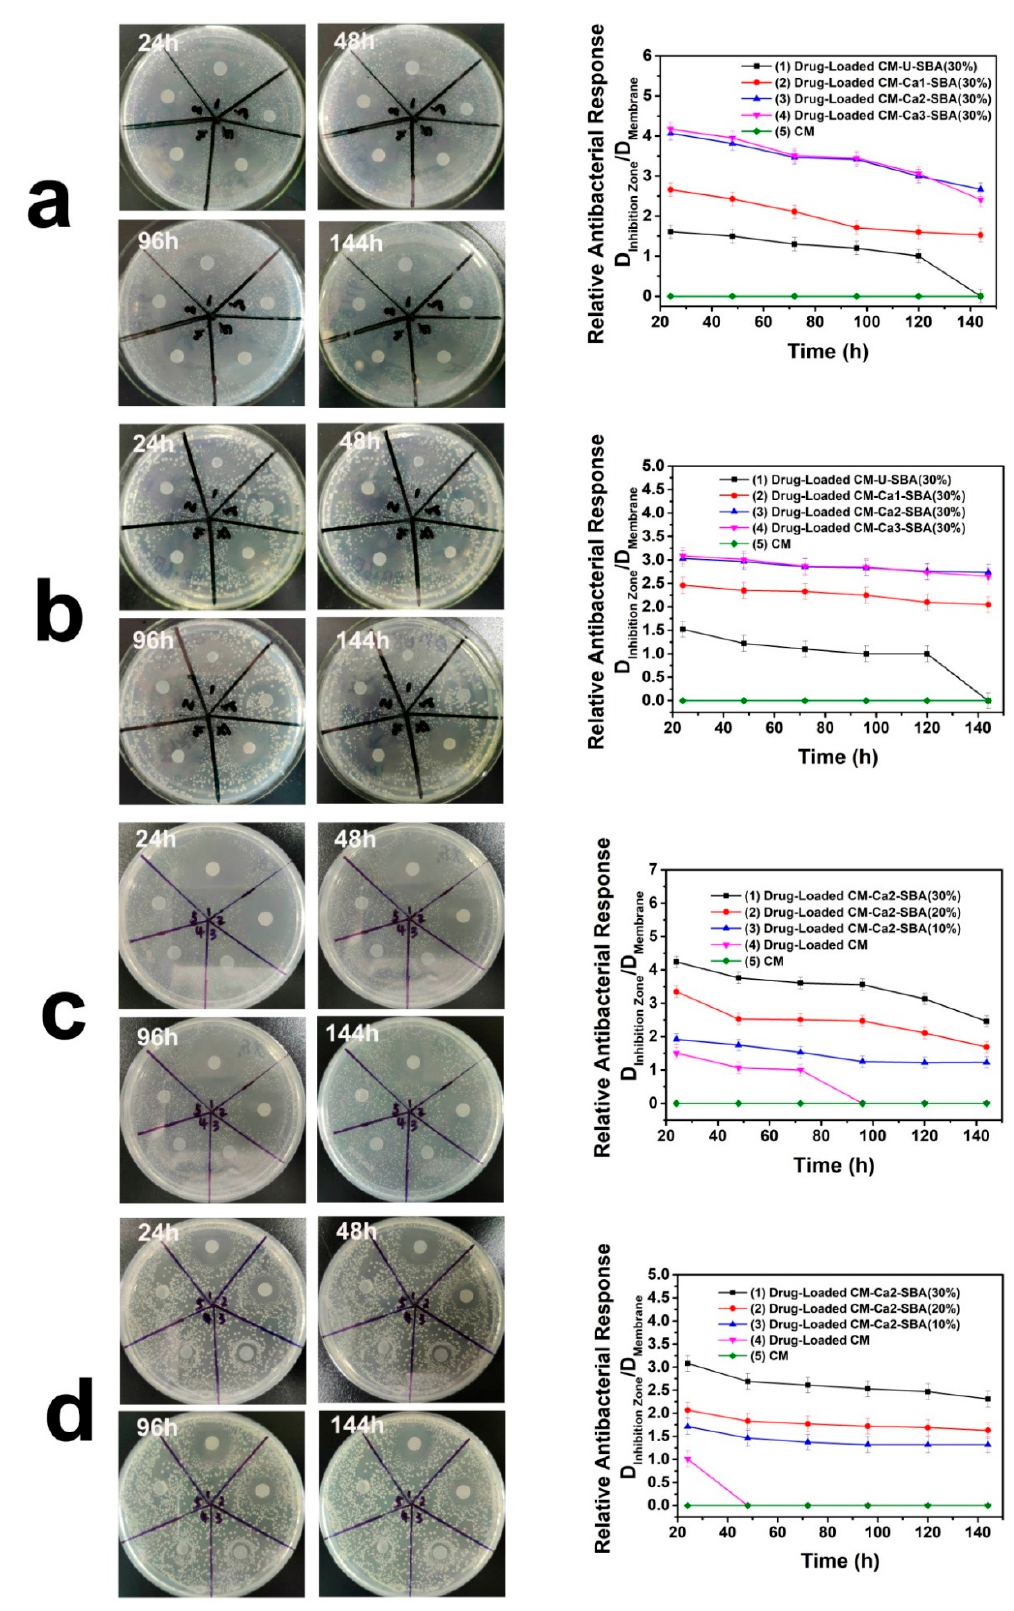
Figure 7. Photograph and the relative antibacterial response of chloramphenicol-loaded plain CM and CM-based membranes against ( a , c ) S. aureus and ( b , d ) E.coli.